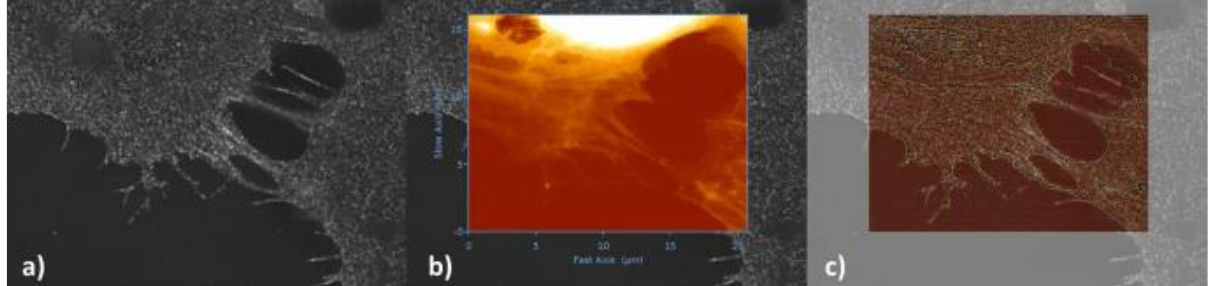
Fig. 2. SR-SIM images of the human bone osteosarcoma epithelial cells (a) superimposed with the height/topography channel of the AFM data (b). The correlated SR-SIM/AFM channels on cells in a semi-transparent mode (XY-scales of the AFM image in (b) (c), include a mean-curvature enhanced AFM-topographic information